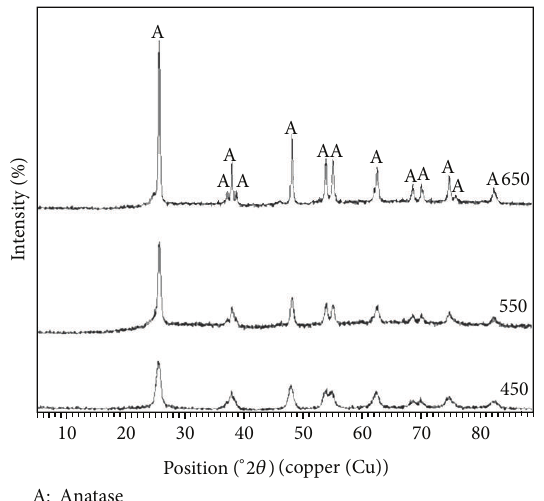
Figure 11: XRD patterns of the unsupported polymeric titania membranes at different calcination temperatures.